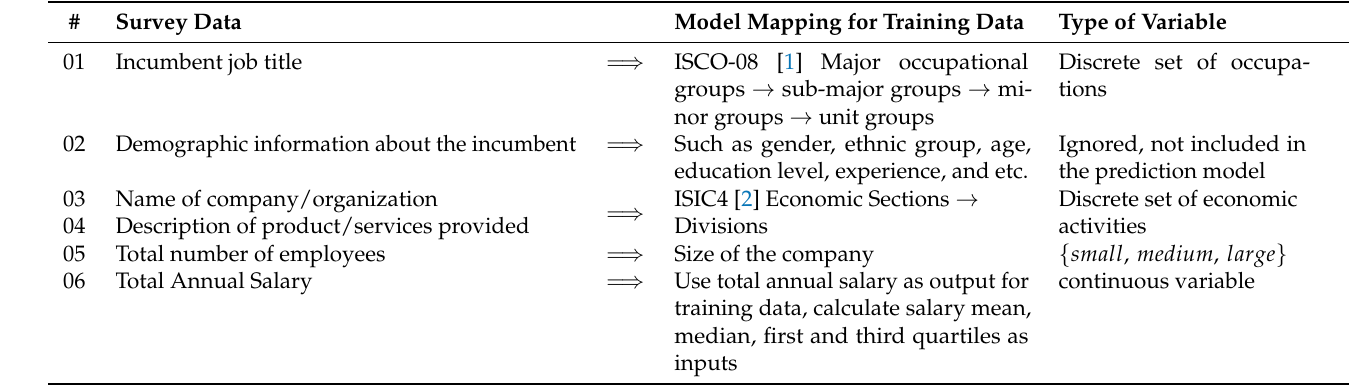
Table 3. Salary survey for prediction